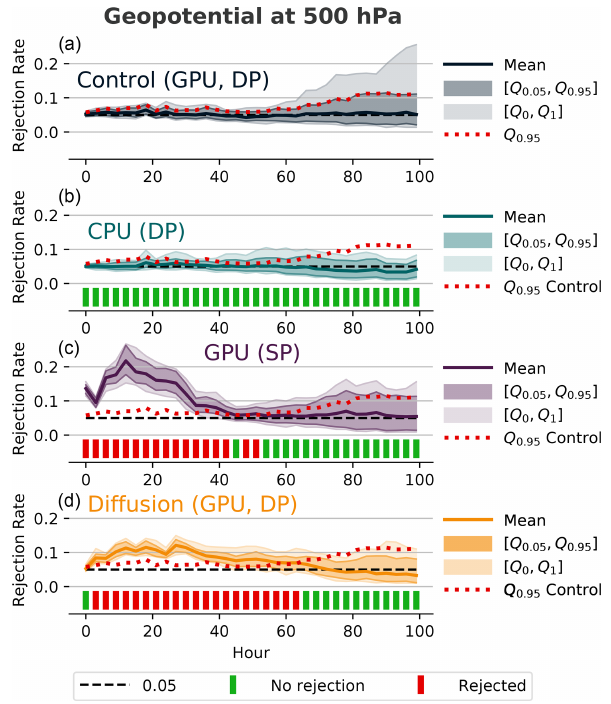
Figure 3. Rejection rates and decisions for H 0 ( global ) for the 500hPa geopotential using the MWU test as an underlying statisti- cal hypothesis test with an ensemble size of n E = 100 and m = 100 randomly drawn subsamples with a subsample size of n S = 50. The reference and control ensembles were produced by COSMO run- ning on (a) GPUs in double precision, whereas the evaluation en- sembles were produced by COSMO running on (b) CPUs in double precision, (c) GPUs in single precision, and (d) GPUs in double precision with additional explicit diffusion ( D = 0 . 005). We reject the null hypothesis if the mean rejection rate is above the 95th per- centile of the rejection rate distribution from the control ensemble (dotted red line). The test detects no differences for the CPU ver- sion in DP, but it detects differences for the other two ensembles during the first few hours or days. The rejection of the initial condi- tions of the SP ensemble is most likely associated with differences in the diagnostic calculation of the geopotential due to the reduced